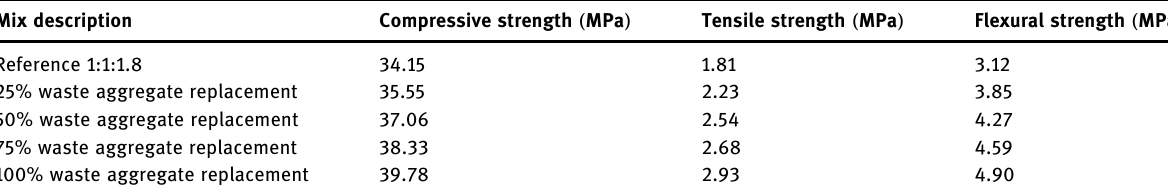
Table 6: Mechanical properties of reference and waste tile aggregate concrete Mix description